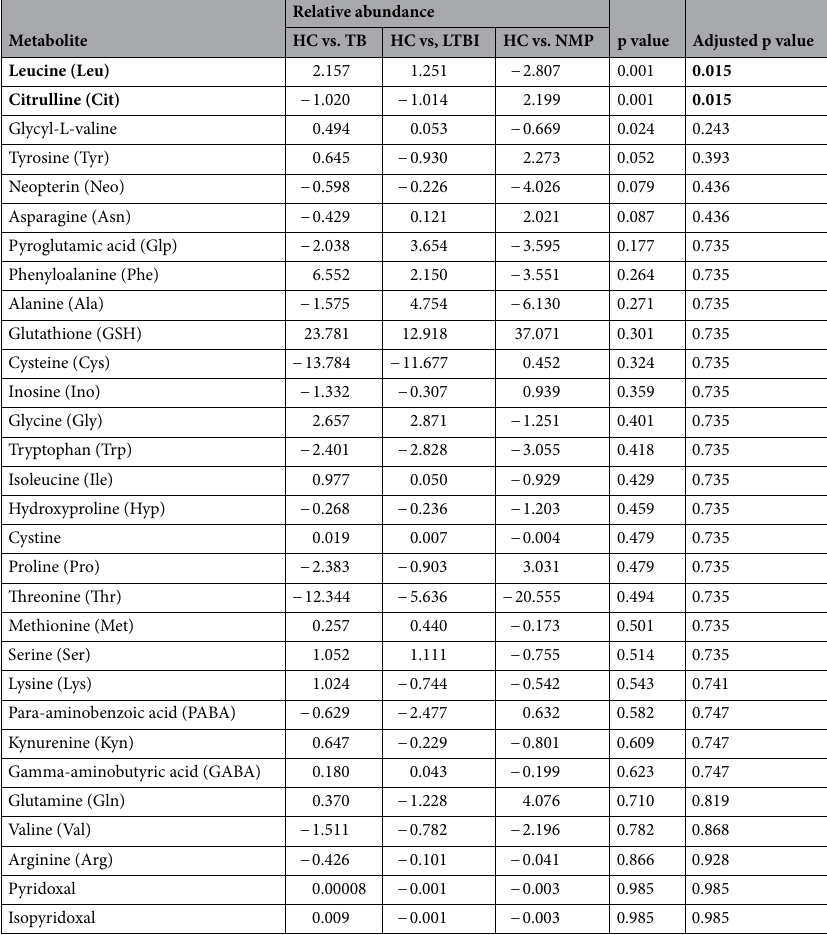
Table 2. Relative abundance of individual metabolites in serum. HC M.tb -uninfected healthy controls, LTBI latently M.tb -infected individuals, NMP patients with nonmycobacterial pneumonia, TB active tuberculosis